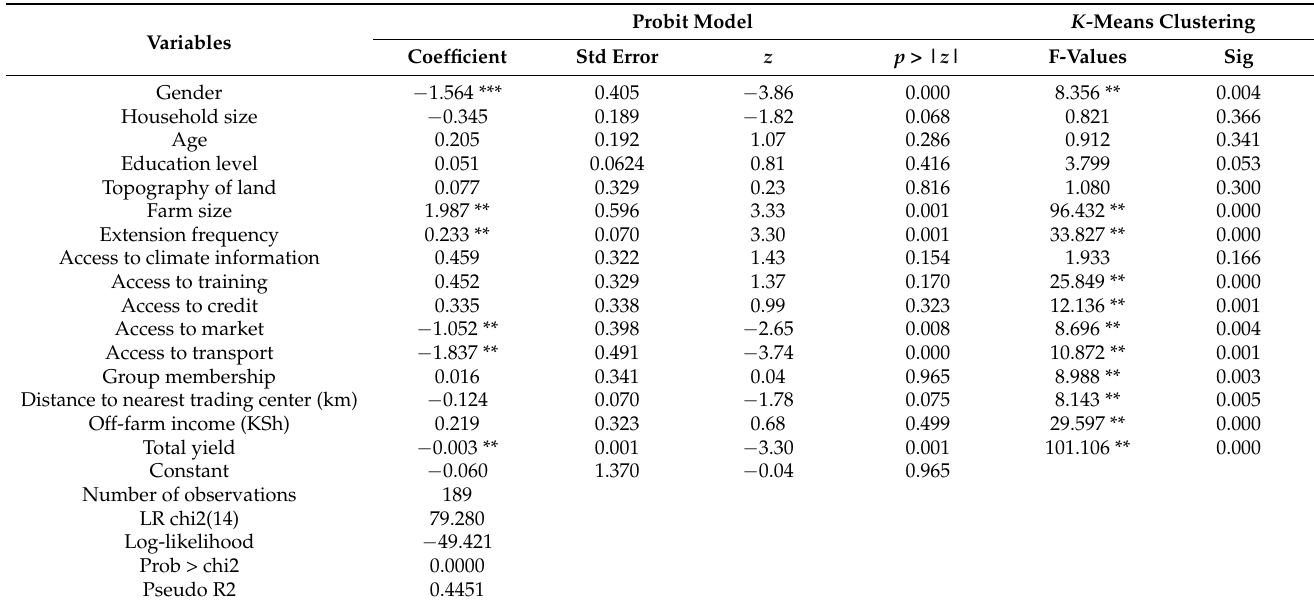
Table 3. Factors that influence farmers’ adoption of agroforestry